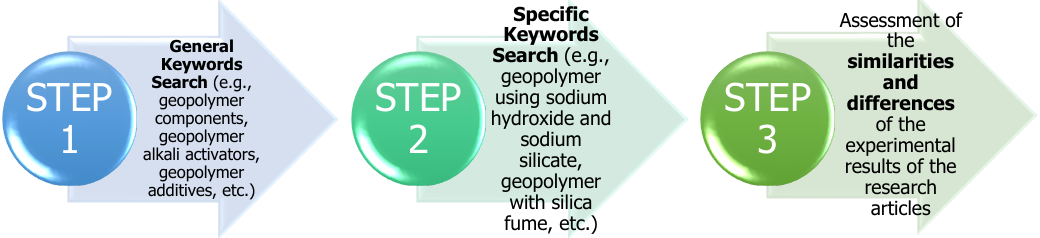
Figure 1. Methodology used in the identification of research articles cited in this review paper.